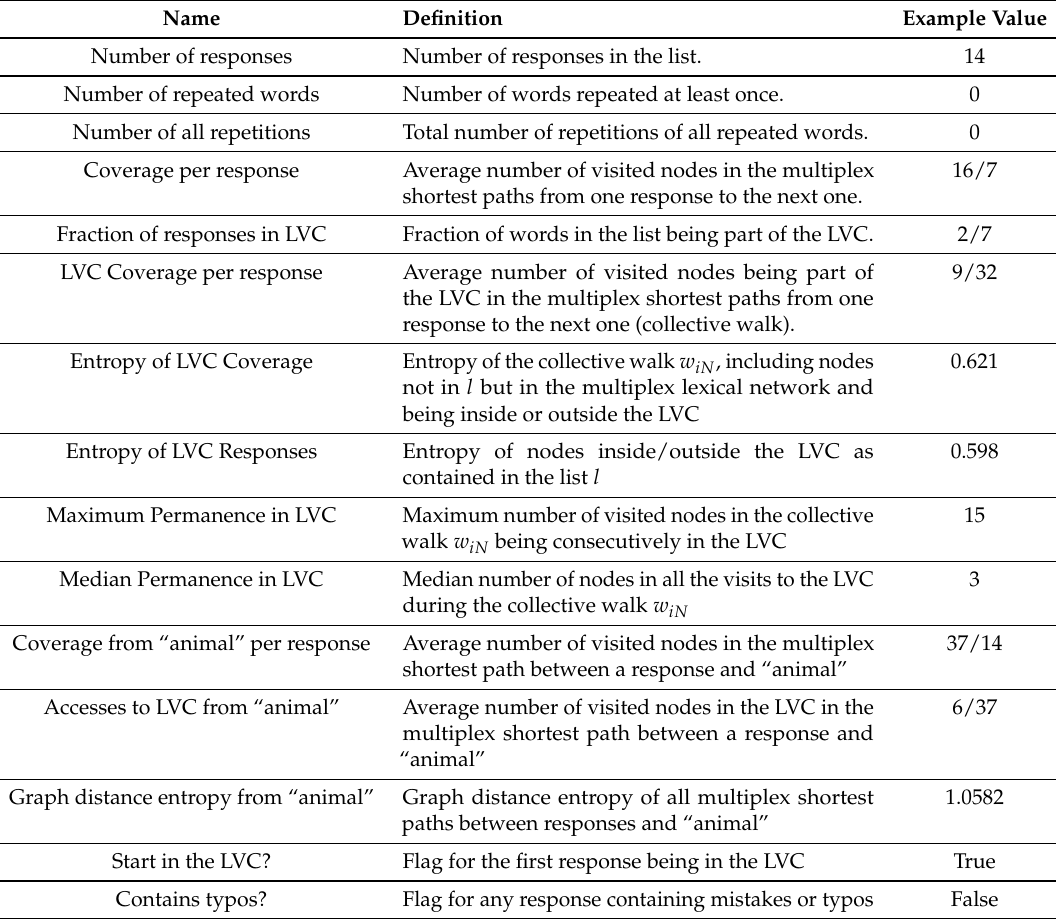
Table 2. Table of tested numerosity and network features of the fluency lists. Example values are reported for the mock fluency list l = l 1 , l 2 , . . . , l N = {“dog”, “cat”, “bird”, “giraffe”, “monkey”, “zebra”, “hedgehog”,“donkey”, “elephant”, “tiger”, “bear”, “snake”, “lizard”,